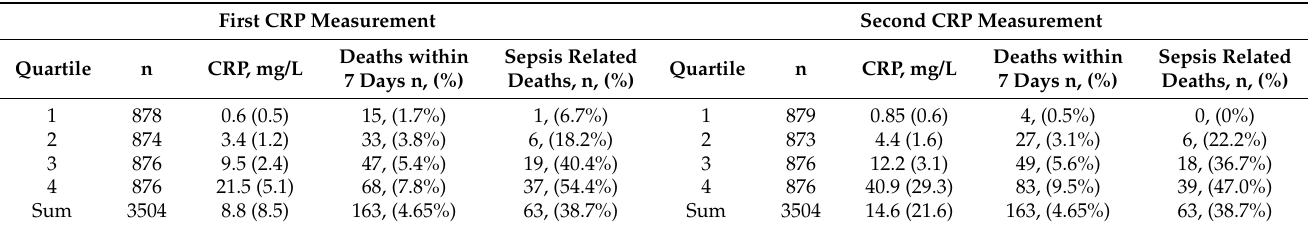
Table 3. The number of patients who died within 7 days according to the quartiles of the first and second CRP